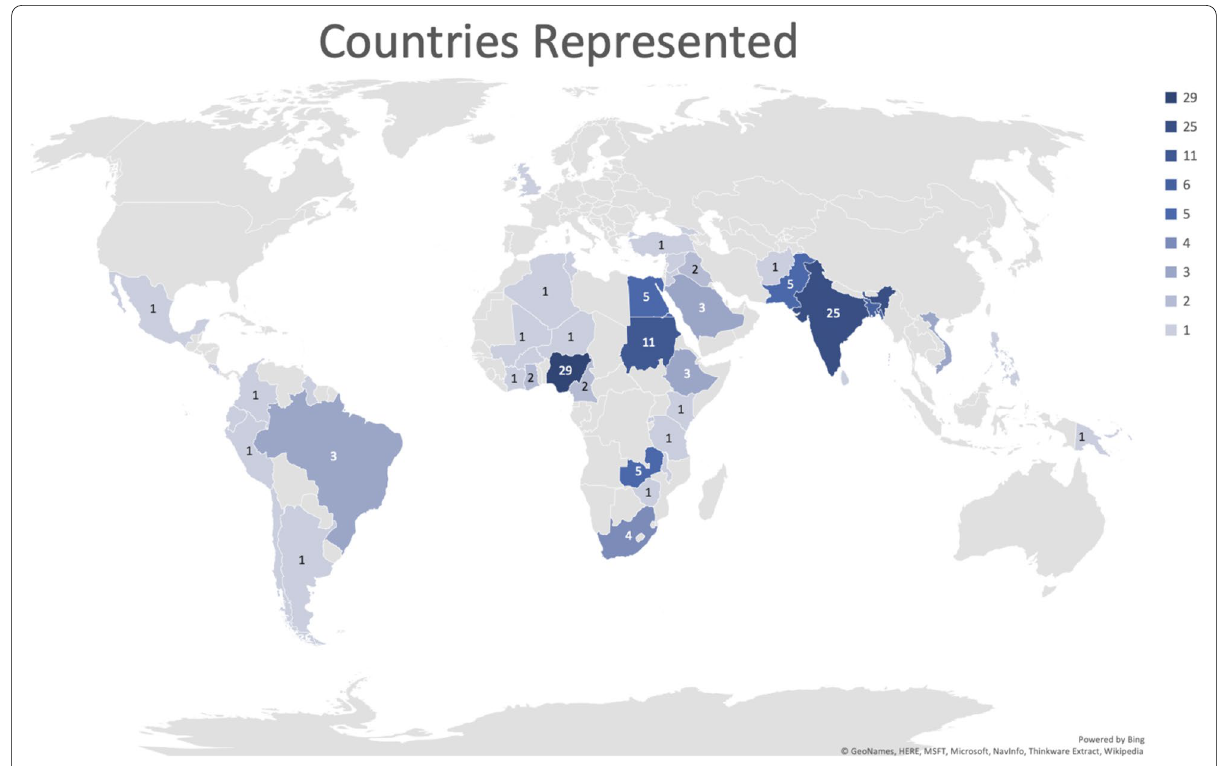
Fig. 2 Survey respondents by